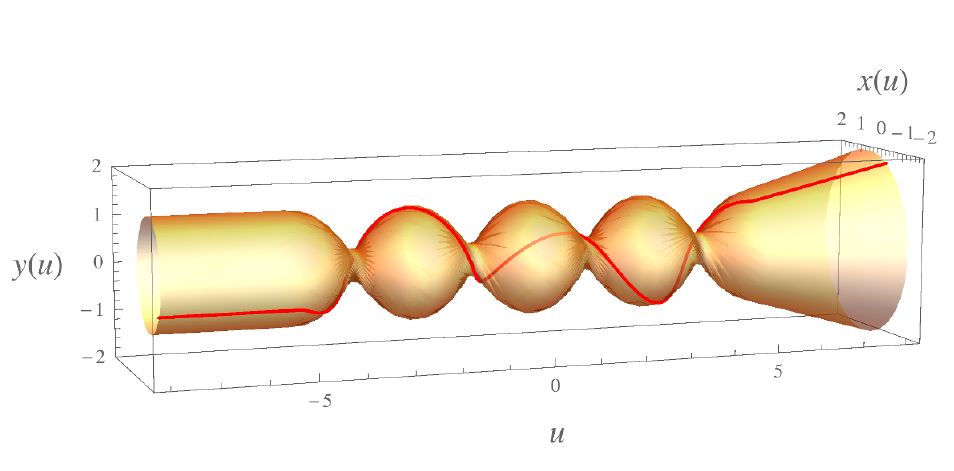
Figure 9 . The red curve shows a single geodesic orbiting around the gyraton centred on r = 0. The shaded envelope is the set of geodesics with the same impact parameter b but di(cid:11)erent initial angles (cid:30) to the gyraton